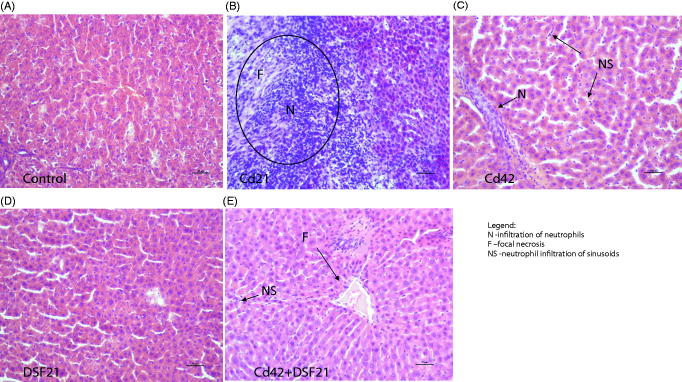
Representative photomicrographs of liver sections from Wistar rats exposed i.p. to 1 mg CdCl2/kg BW/day (for 21 and 42 days) and orally to 178.5 mg DSF/kg BW/day (for 21 days), individually and/or in combination: (A) Control/intact group, showing normal appearance; (B) Cd21: showing infiltration of neutrophils (N) and focal necrosis (F). (C) Cd42: showing infiltration of neutrophils (N) and neutrophil infiltration of sinusoids (NS). (D) DSF21: showing normal appearance; and (E) Cd42 + DSF21: group showing infiltration of neutrophils (N), neutrophil infiltration of sinusoids (NS) and focal necrosis (F).